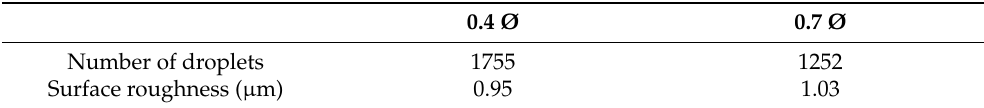
Table 2. Number of holes and surface roughness result by nozzle